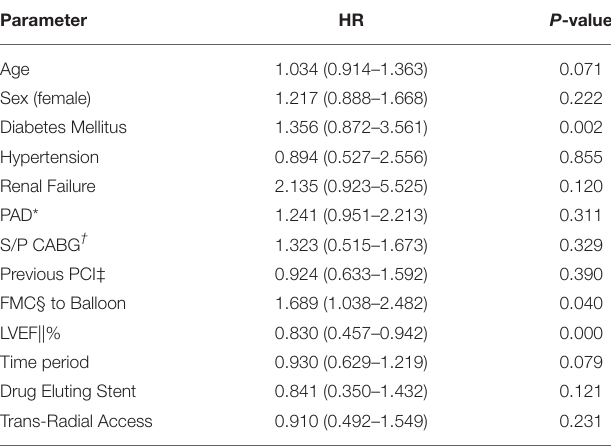
TABLE 4 | Multivariate analysis for the risk of